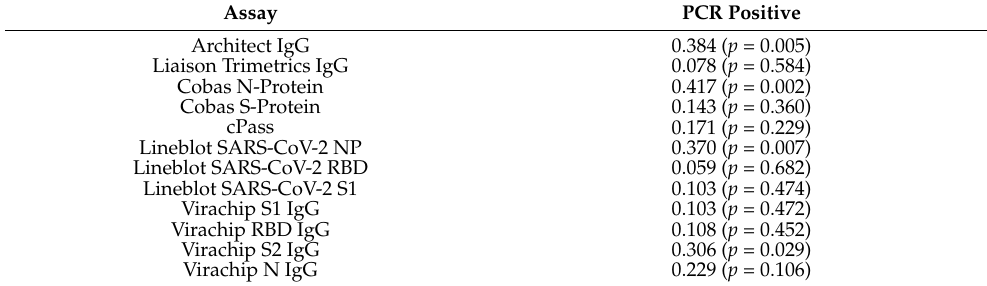
Table A3. Spearman correlation coefficients between all individual assays and Ct values (PCR-positive